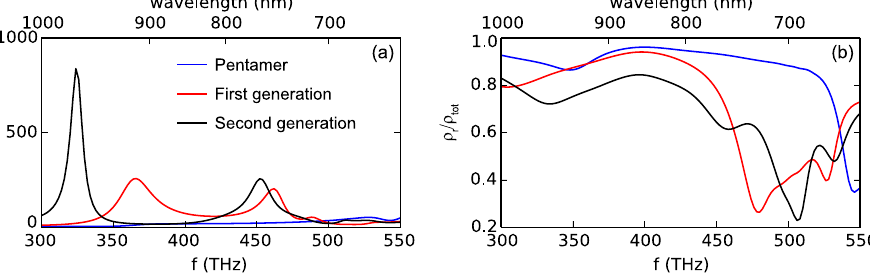
Figure 5. ( a ) Total decay rate enhancement ρ tot from the Ag pentamer, first and second generation of dendritic antennas and ( b ) ρ r / ρ tot , i.e., maximum achievable antenna quantum efficiency, as simulated by